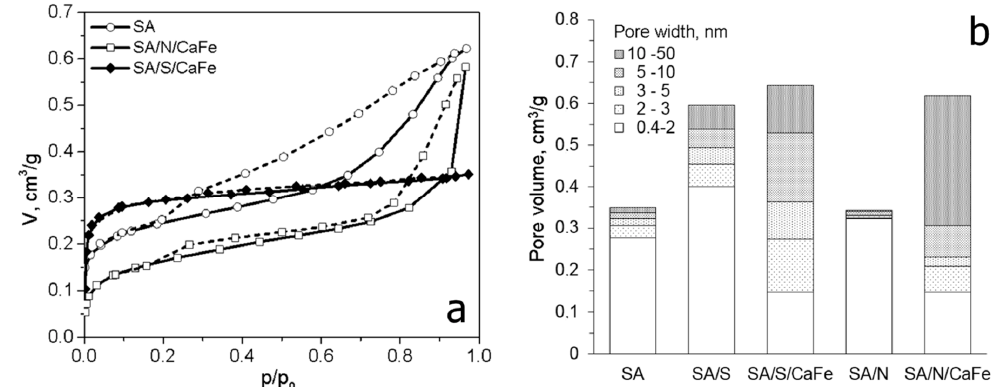
Figure 18. Adsorption isotherms of benzene at 25 °C ( a ) and pore volume distribution ( b ) of ACs prepared from bituminous coal. SA-AC from bituminous coal; SA/N/CaFe and SA/S/CaFe—AC produced from the oxidized coal (N) and sulphonated (S), respectively, and subsequently loaded with Ca and Fe by ion exchange. Solid lines—adsorption branch, dashed lines—desorption branch. Reproduced from [130] with permission from Elsevier ©